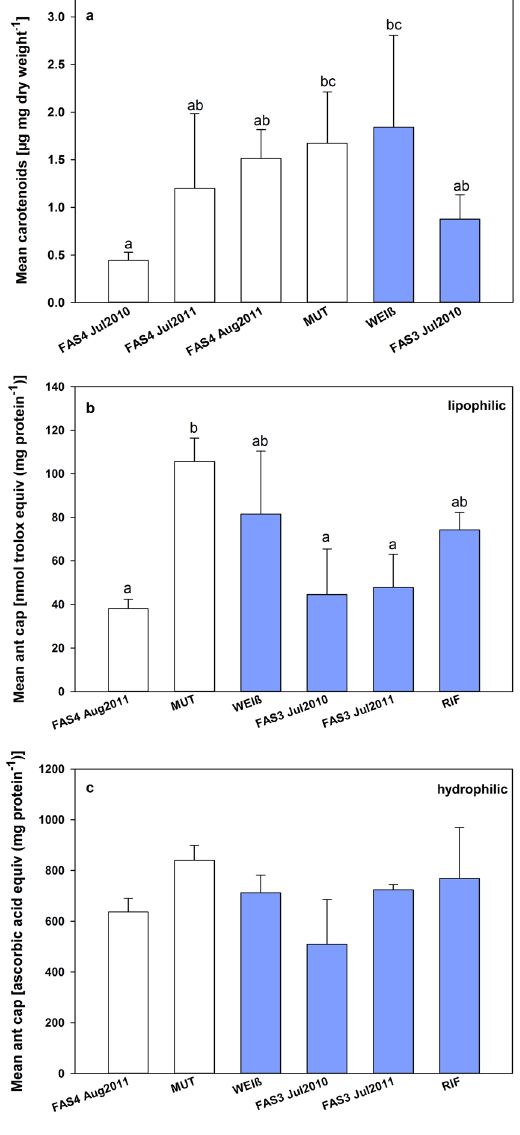
Figure 6. Total mean carotenoid concentrations ( µ g mg dry weight − 1 ) in Cyclops abyssorum tatricus copepodid CI to adult life stages ( a ), and mean lipophilic antioxidant capacity (ant cap) (nmol trolox equivalents mg protein − 1 ) ( b ), and mean hydrophilic antioxidant capacity (nmol ascorbic acid equivalents mg protein − 1 ) ( c ) in C . abyssorum tatricus copepodid CI–CV life stages from clear (white bars) and turbid glacier-fed (blue bars) alpine lakes sampled during the ice-free period of 2010 and 2011. The lakes are ordered from clear to turbid (abbreviations for the lakes are defined in Table 1). Error bars indicate + 1 standard deviation. Different letters above the bars indicate a significant difference found with Kruskal-Wallis one-way ANOVA on Ranks, all pairwise multiple comparison procedures (Dunn’s method, p < 0.05) ( a ), and with one-way ANOVA, all pairwise multiple comparison procedures (Holm-Sidak method, F 5,12 = 7.31, p = 0.002) ( b ).